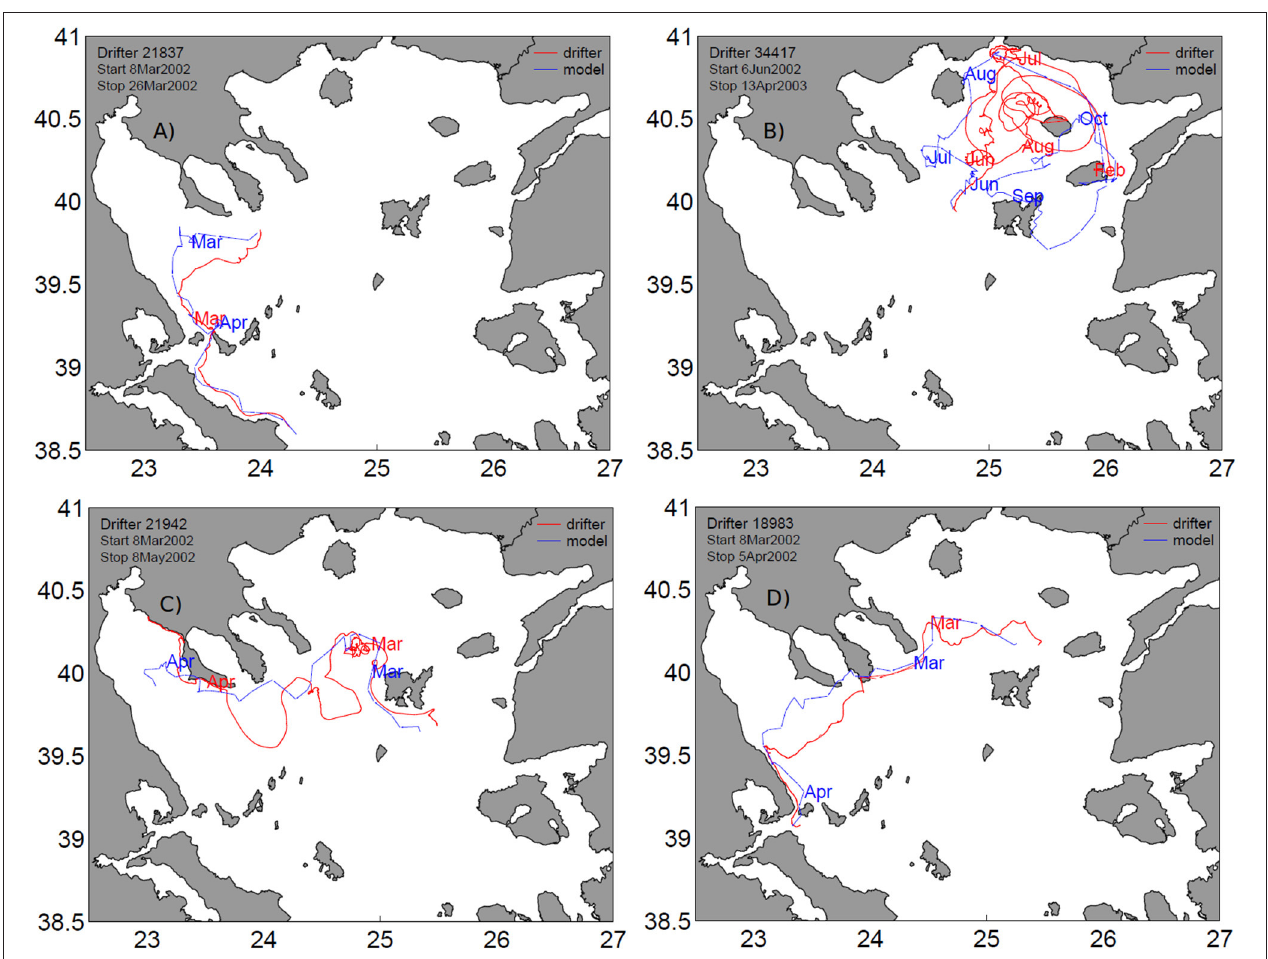
FIGURE 4 | Simulated drifter tracks (blue line) against observed drifter tracks (red line) in 2002 (Olson et al., 2007). Fifty model drifters are released on the same time period and within a small radius from the actual release location to remove sensitivity from initial release. The best model drifters in reproducing the observed patterns are shown: (A) drifter 21837, (B) drifter 34417, (C) drifter 21942, and (D) drifter 18983. The month is indicated on its 15th day along the simulated (blue color) and observed (red color) drifter